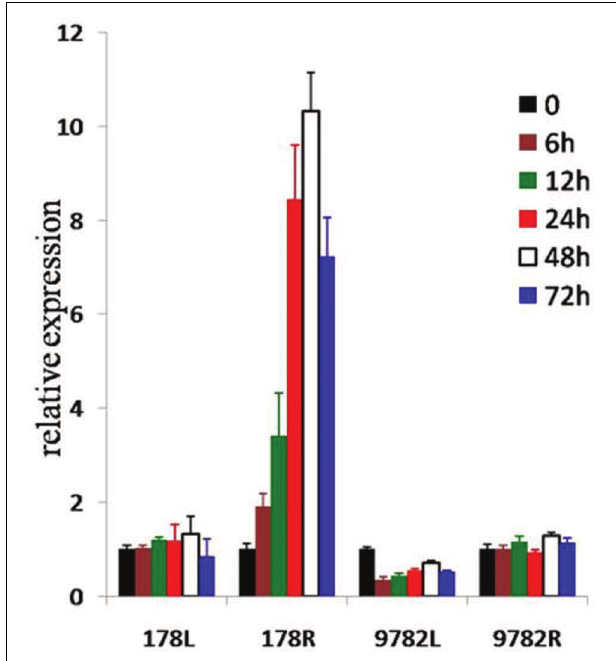
FIGURE 5 | Expression analysis of ZmARF31 in low-phosphorus- tolerant and low-phosphorus-sensitive inbreds, 178 and 9782. Low phosphorus stress was conducted at seedling stage with treatments of 0, 12, 24, 48, and 72 h. L, leaves; R,